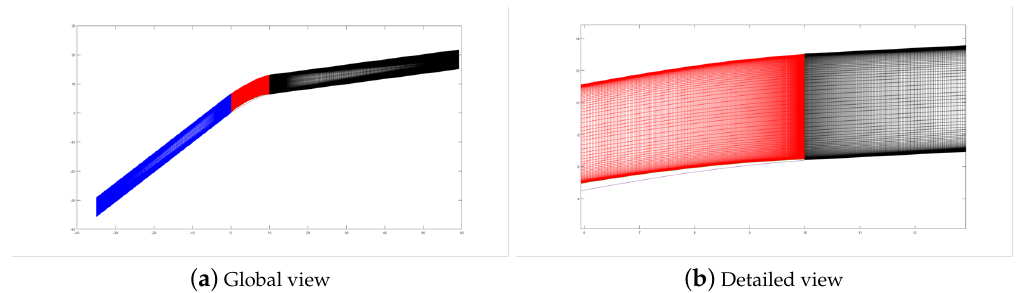
Figure 12. Illustration of flow between blades.